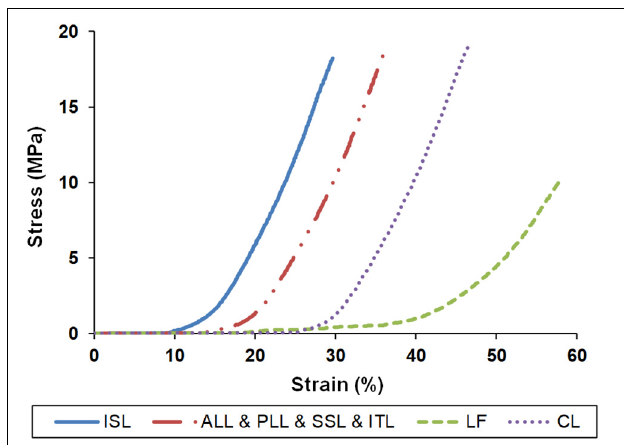
FIGURE 2 | Stress–strain properties of the ligaments for finite element modeling. ISL, interspinous ligament; ALL, anterior longitudinal ligament; PLL, posterior longitudinal ligament; SSL, supraspinous ligament; ITL, intertransverse ligament; LF, ligamentum flavum; CL, capsular